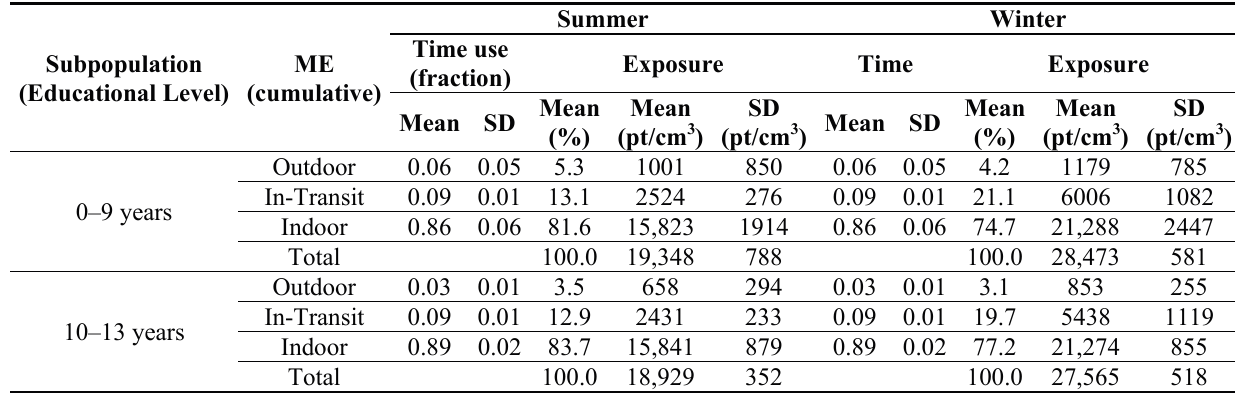
Table 7. Summary of the mean simulated exposures, segregated for cumulative MEs and seasons. Results are calculated for subpopulations segregated by educational level ( i.e. , year of